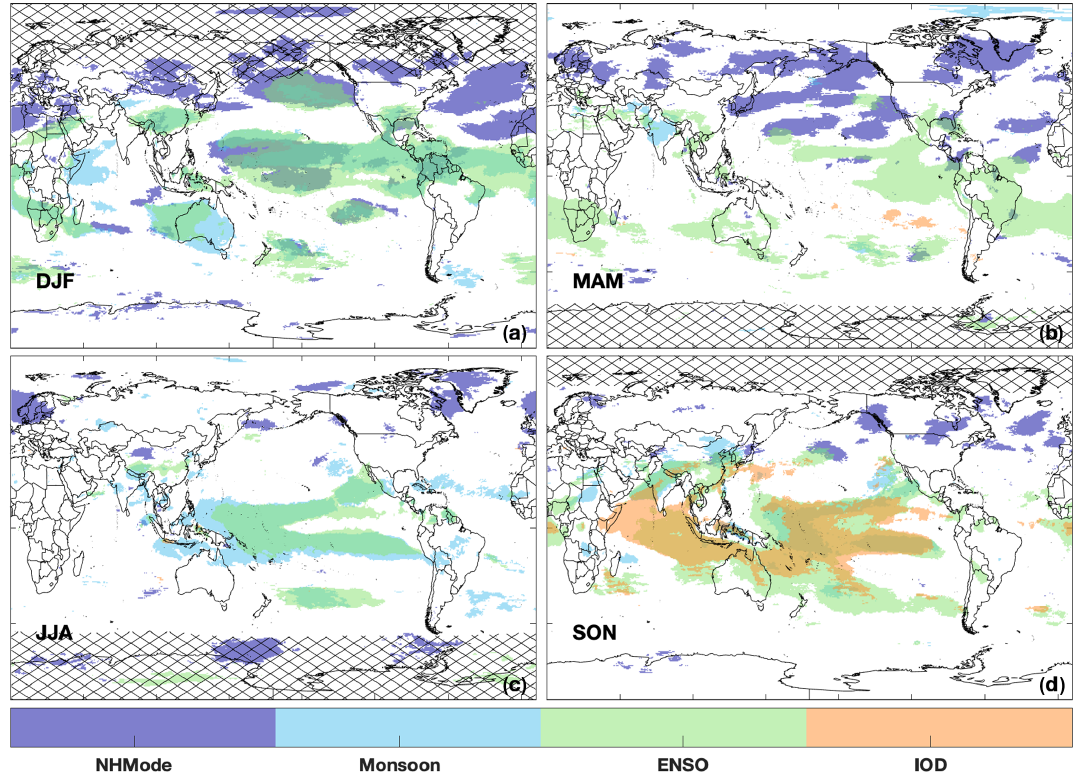
Figure 5. Regions that show a significant correlation (absolute value of r > 0.5) between a NH mode (purple), monsoon (light blue), ENSO (green), or IOD (orange) and TCOH for each season in the MERRA-2 GMI simulation. Regions with TCOH less than 1 × 10 11 molec . cm − 2 have been hatched out.